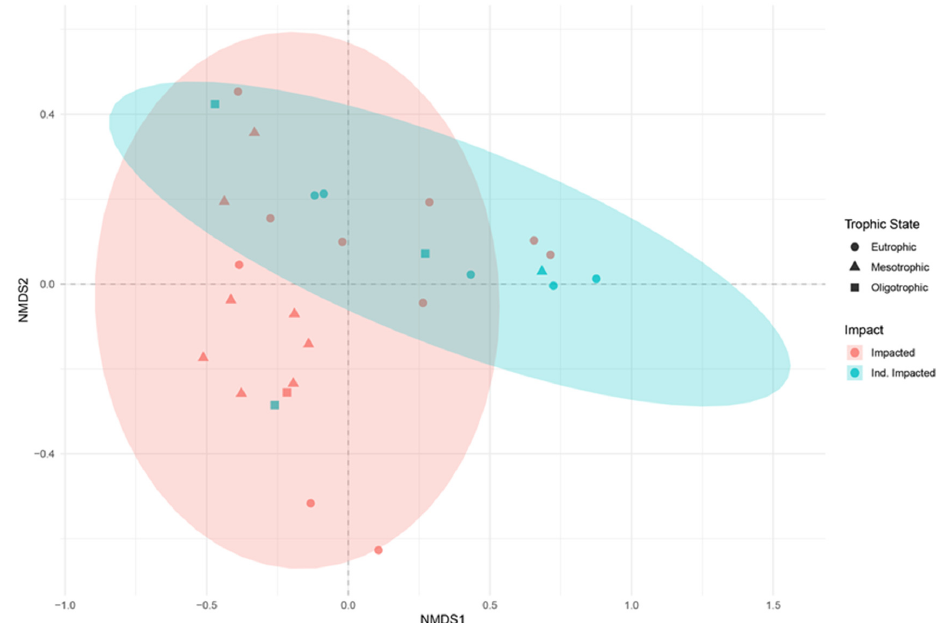
Figure 5. Non-metric Multidimensional Scaling ordination, within two dimensions of protists communities within sampling sites, during 5–10 October 2019, along the New River, Belize. Legend shows trophic state and impact status. Ellipses represent the location of group centroids to at a 0.95 confidence level. Stress level: 0.07.